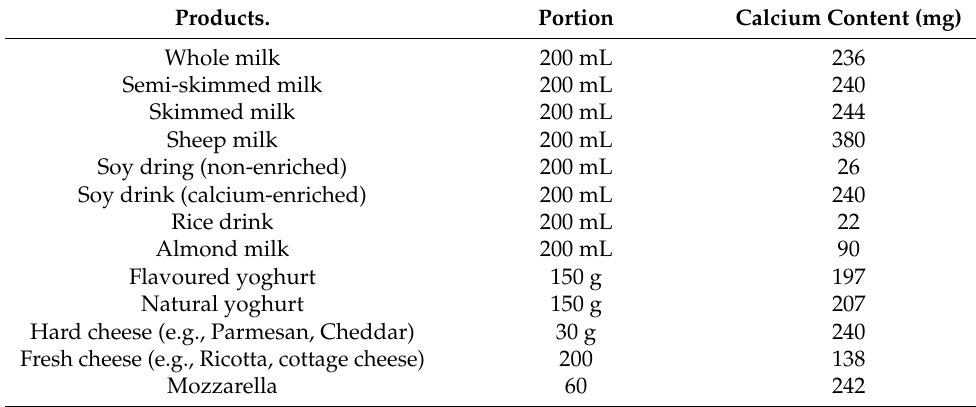
Table 1. Calcium content in selected products